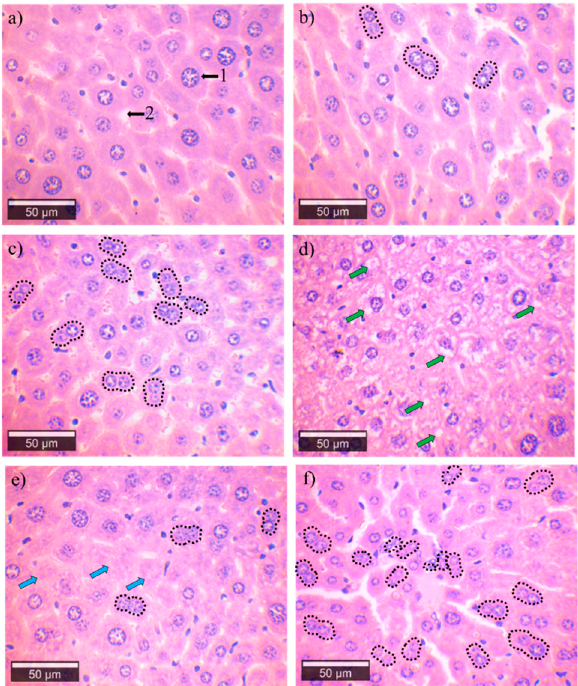
Figure 5. Microphotographs of the medial areas of the mice liver to an increase 50 × , (1) sinusoid and (2) hepatocyte. ( a ) Control group showing the normal structure in hepatocytes. ( b ) C ó corit, ( c ) V í cam, and ( d ) P ó tam groups show regeneration of hepatocytes (binucleations) (black); and vacuolation (green arrow). P ó tam group showing ( e ) necrotic hepatocytes (blue arrows) and ( f ) regenerative binucleation